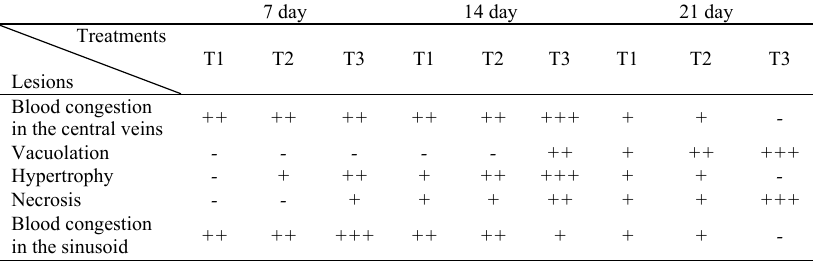
Table 2: Histopathological scores of Caspian roach liver exposed to continuous exposure of CuNPs 7 day 14 day 21 day Treatments